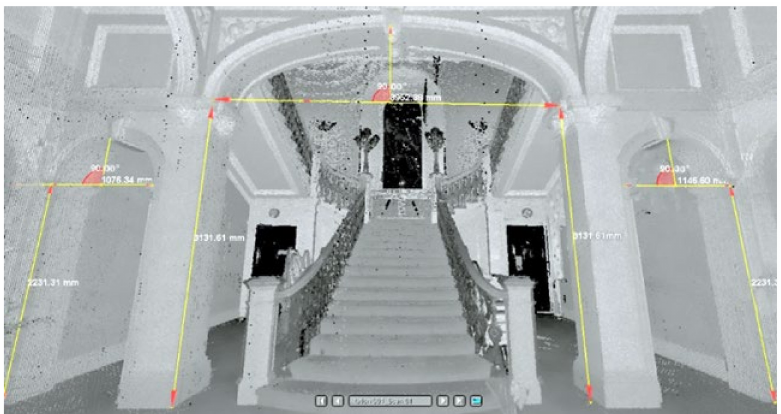
Figure 12. Investigation of the main hall elements of the Headington Hill Building.